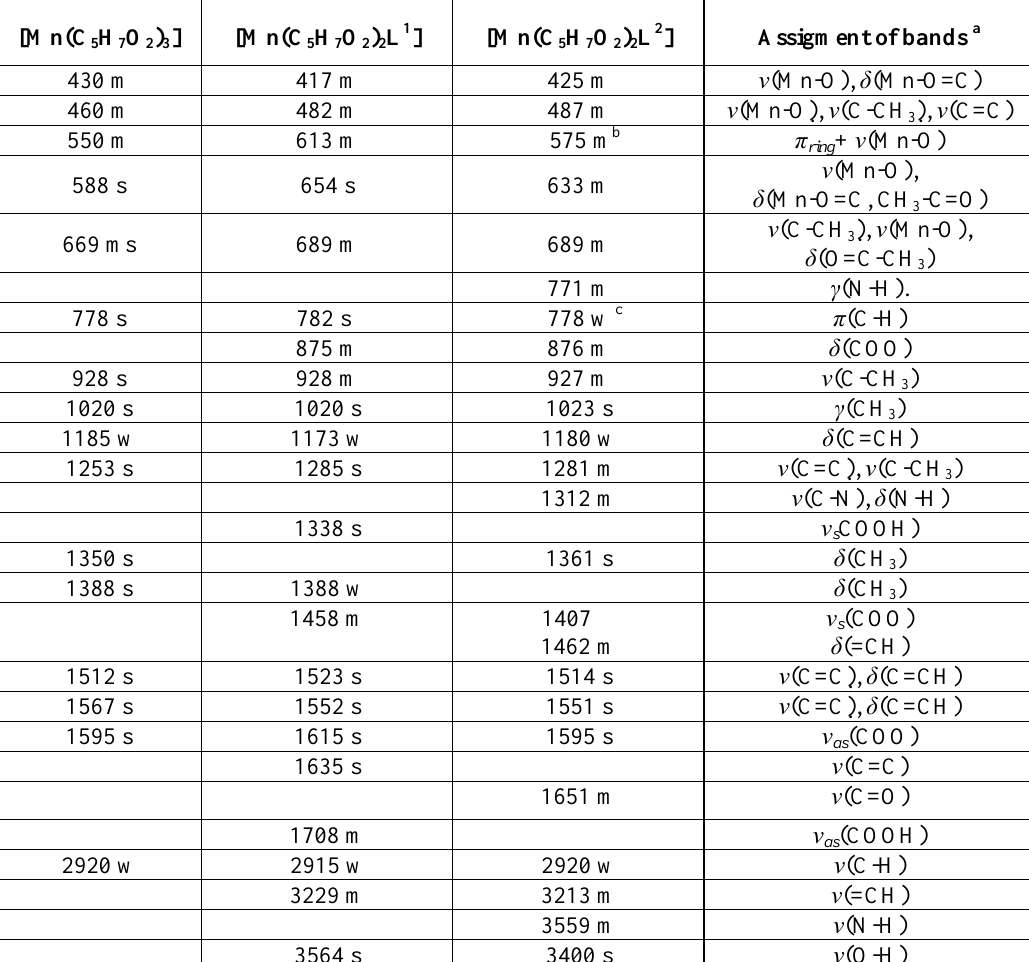
Table 2. The FTIR spectral data of the compounds [frequency (cm -1